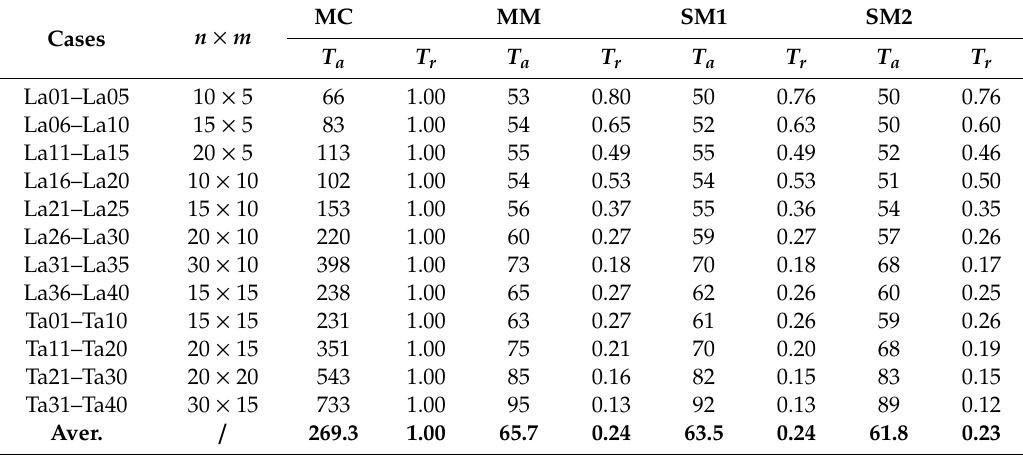
Table 7. Results on the CPU time (in seconds) of algorithms MC, MM, SM1, and